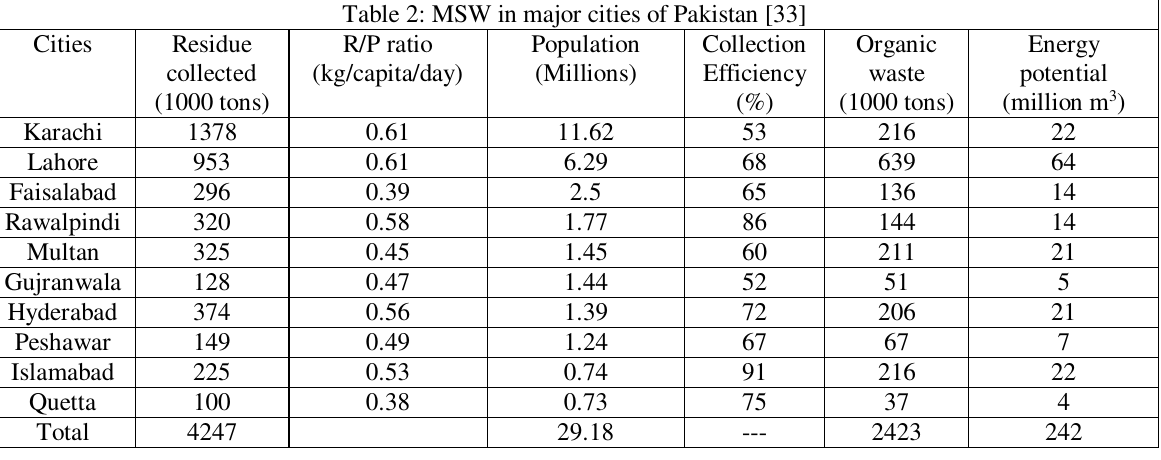
Table 2: MSW in major cities of Pakistan